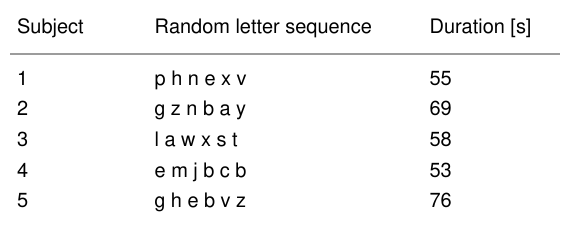
Table 2: Summary of generated random letter sequences with corre- sponding typing duration using eye